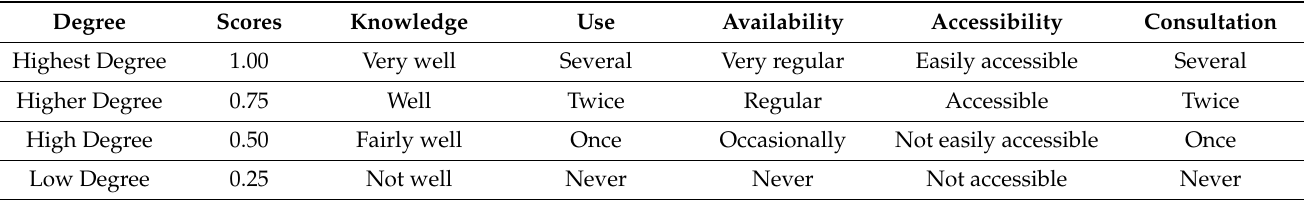
Table 1. Scores of farmers’ achievement of attributes.